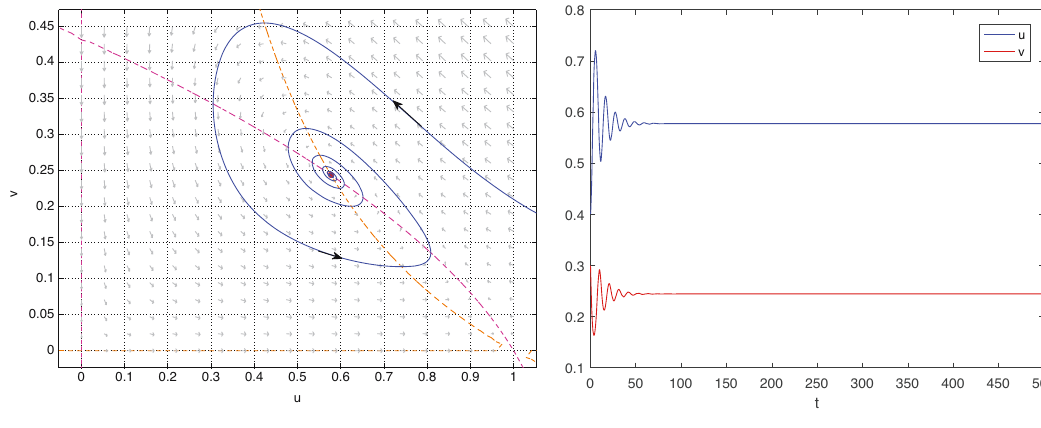
Figure 1: Phase portraits of model ( 1.4 ) with parameter = σ 1 , the equilibrium